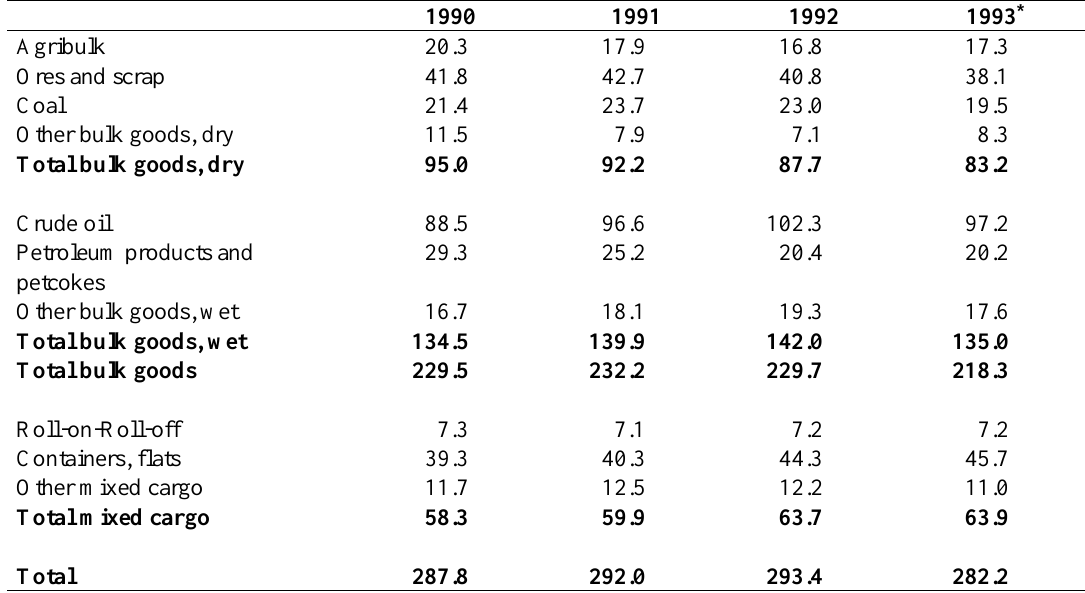
Table 8. Transhipment by type of goods in the port of Rotterdam, from 1990 to 1993 (in million tons gross